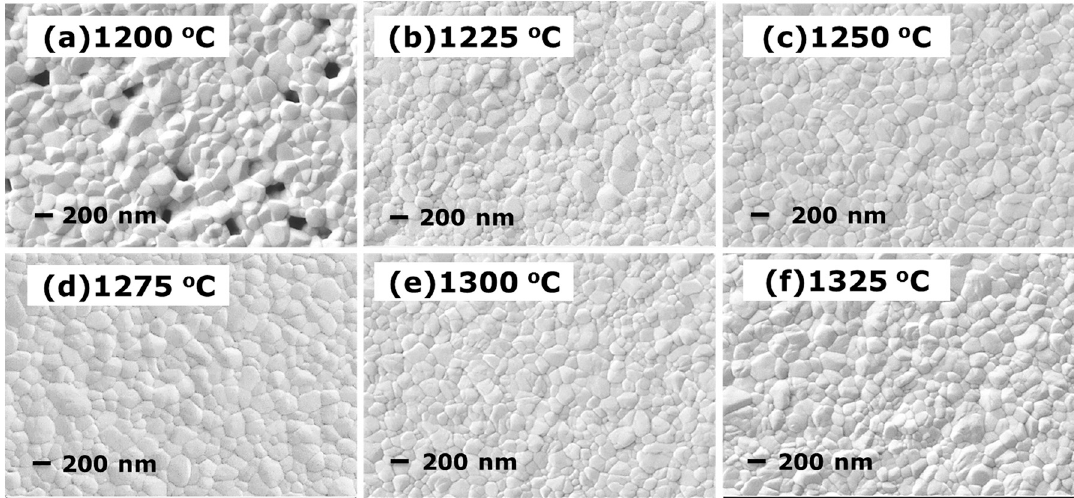
Figure 4. SEM micrographs of samples HIPed at 1275 °C with a pre-sintering temperature of ( a ) 1200 °C; ( b ) 1225 °C; ( c ) 1250 °C; ( d ) 1275 °C; ( e ) 1300 °C and ( f ) 1325 °C.